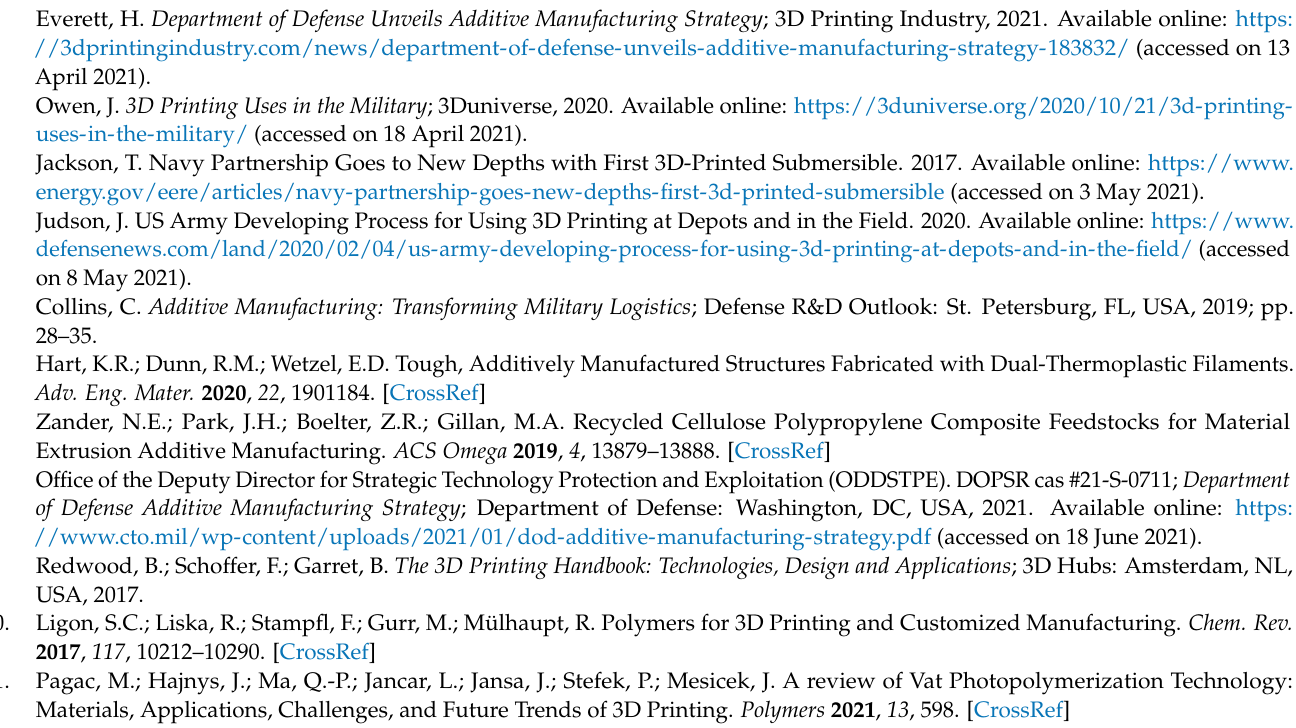
and Tan-d; (Bottom) Loss modulus, Figure S5: Sheer stress as a function of shear rate of of HTM SLA, Figure S6: Sheer stress as a function of shear rate of of 4-methylstyrene, 4-tert butylstyrene and styrene, Figure S7: Sheer stress as a function of shear rate of urethan dimethacrylate UDM, Figure S8: Working curve for HTM SLA resins. Data collected using Anycubic Photon 3D printer, Figure S9: FTIR spectrum of neat Ebecryl 4859, Figure S10: FTIR absorbance spectrum of CN 151, Figure S11: FTIR absorbance spectrum of urethane dimethacrylate UDM, Figure S12: FTIR ab- sorbance spectrum of styrene and its derivatives, Figure S13: Normalized FTIR absorbance spectrum of HTM:Eb4859:tbutylSty (2:1:2 by mass) un-cured and postcured, Figure S14: Normalized FTIR absorbance spectrum of HTM:UDM:tbutylSty (2:1:2 by mass) un-cured and postcured, Figure S15: Normalized FTIR absorbance spectrum of HTM:CN151:tbutylSty (2:1:2 by mass) un-cured and postcured, Figure S16: Normalized FTIR absorbance spectrum of HTM:MeSty:tbutylSty (2:1:2 by mass) un-cured and postcured, Figure S17: TGA thermograms of HTM 3D printed thermosets. Left: thermal decomposition vs. weight percent. Right: first derivative weight